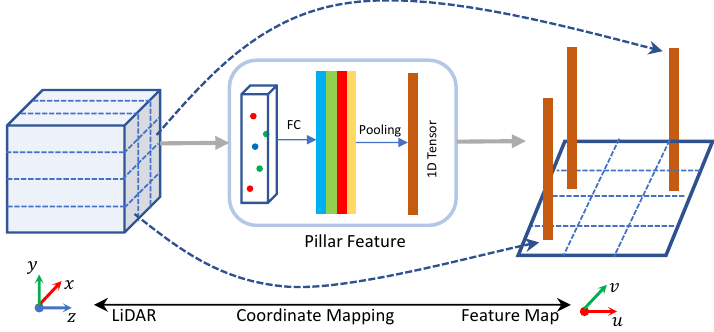
Figure 2. Coordinate mapping relationship between the feature map and LiDAR coordinate system, taking a pillar feature extractor as an